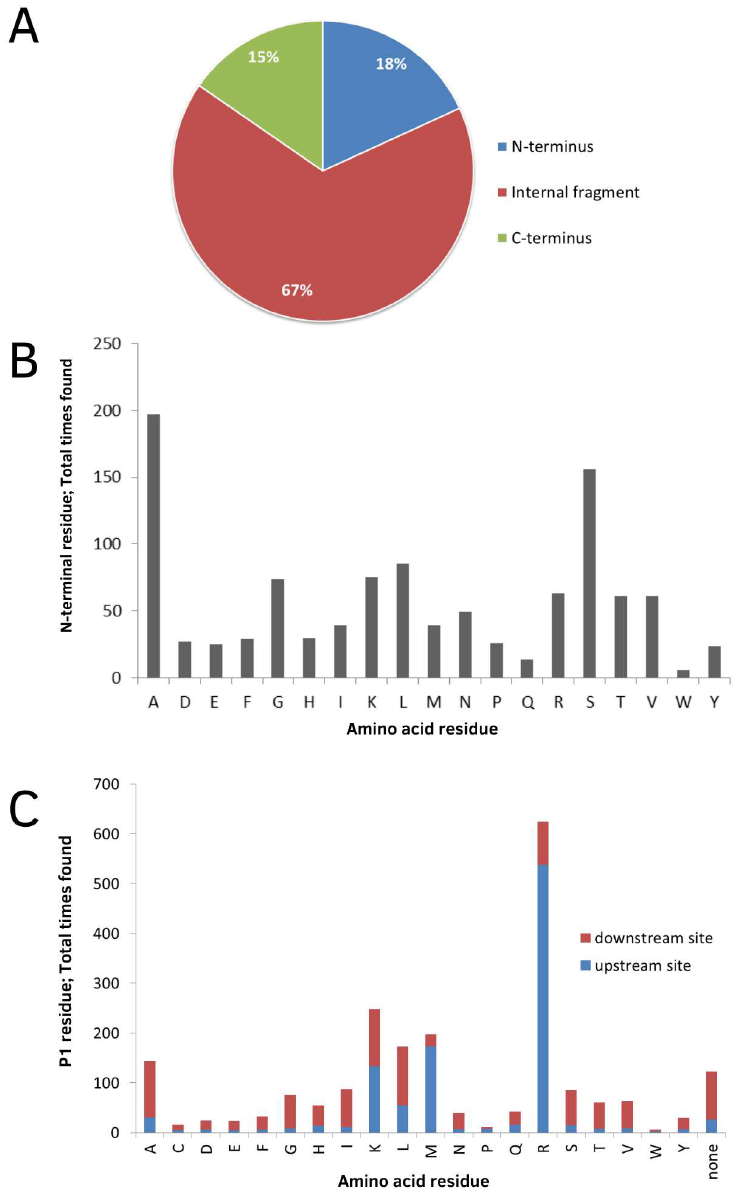
Figure 2. Proteolytic processing of peptides in gills of H. reidi . In ( A ), analysis of the peptide location within the protein precursor. In ( B ), analysis of the N-terminal residues of the peptides; number of times each amino acid is located at the N-terminus considering the 1080 identified peptides. In ( C ), analysis of the cleavage sites required for the formation of the observed intracellular peptides. The number of occurrences of each amino acid at the P1 position of the cleavage site is indicated for both upstream and downstream